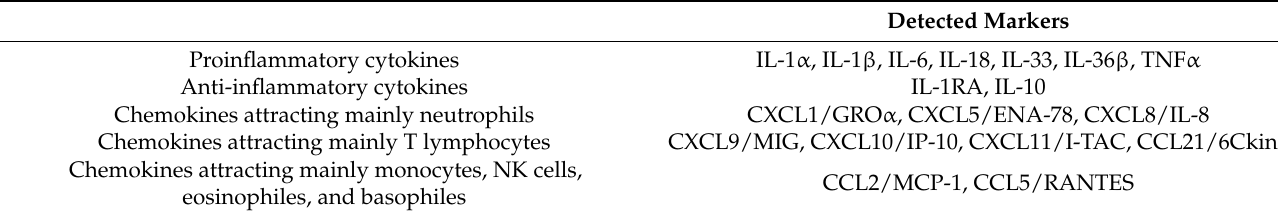
Table 2. Summary of detected cytokines and chemokines by Luminex technology.